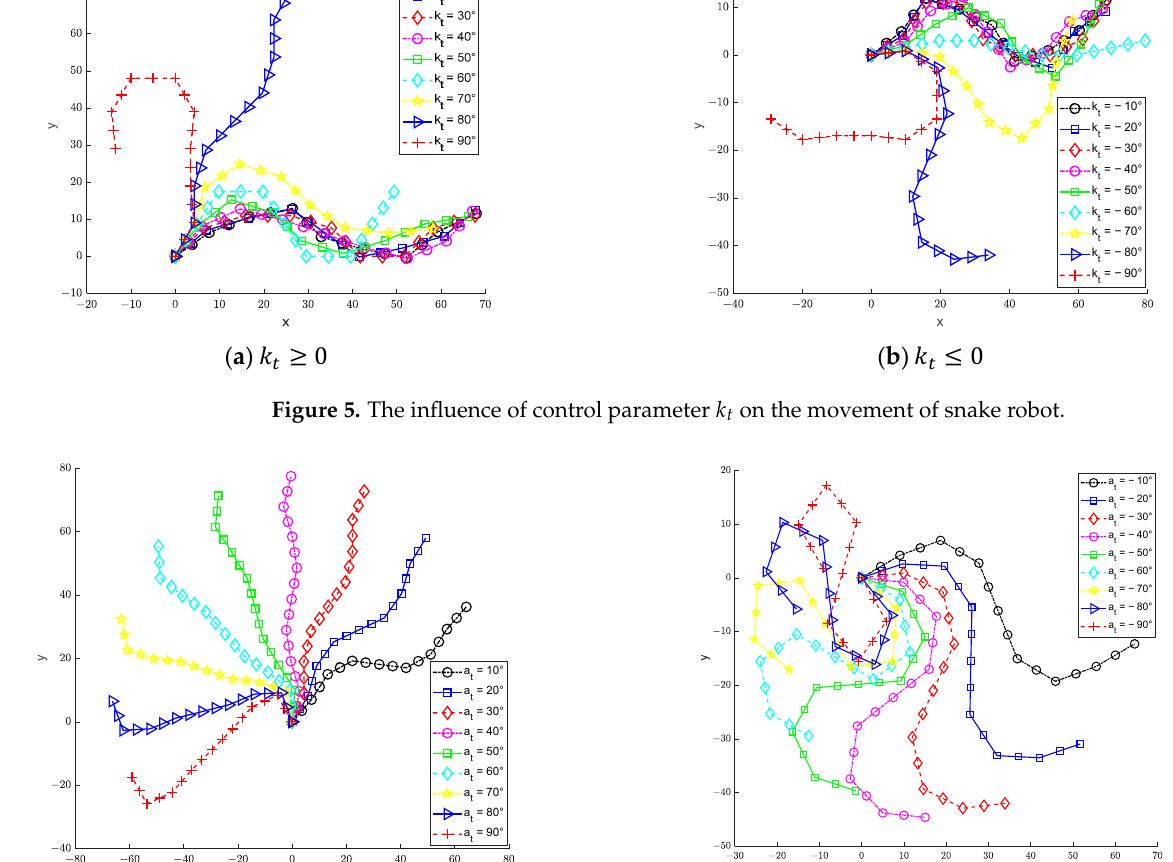
t on the movement of snake